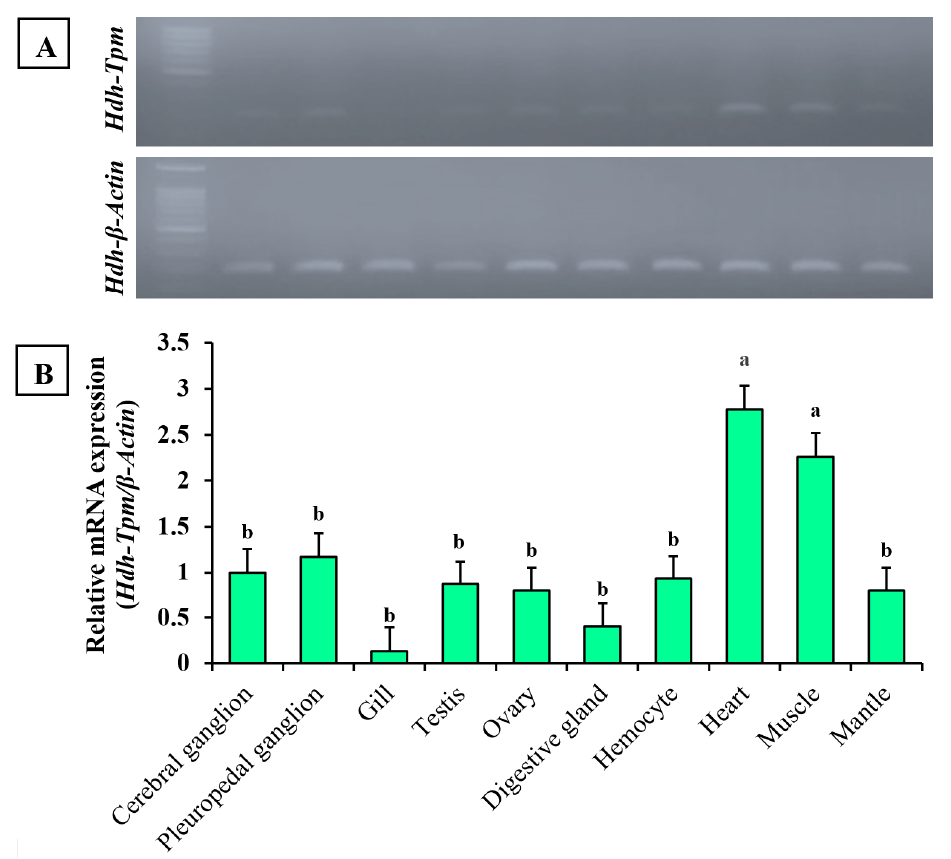
Figure 7. Expression of Hdh-TPM mRNA in different tissues of Pacific abalone H. discus hannai : ( A ) semiquantitative expression; ( B ) quantitative expression. Significantly different levels ( p < 0.05) are denoted by different letters.